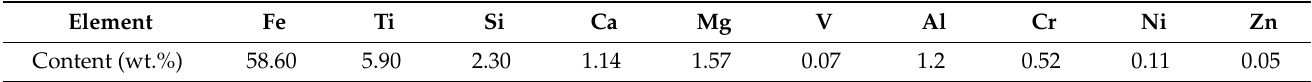
Table 2. Chemical compositions (ICP) of secondary roasted